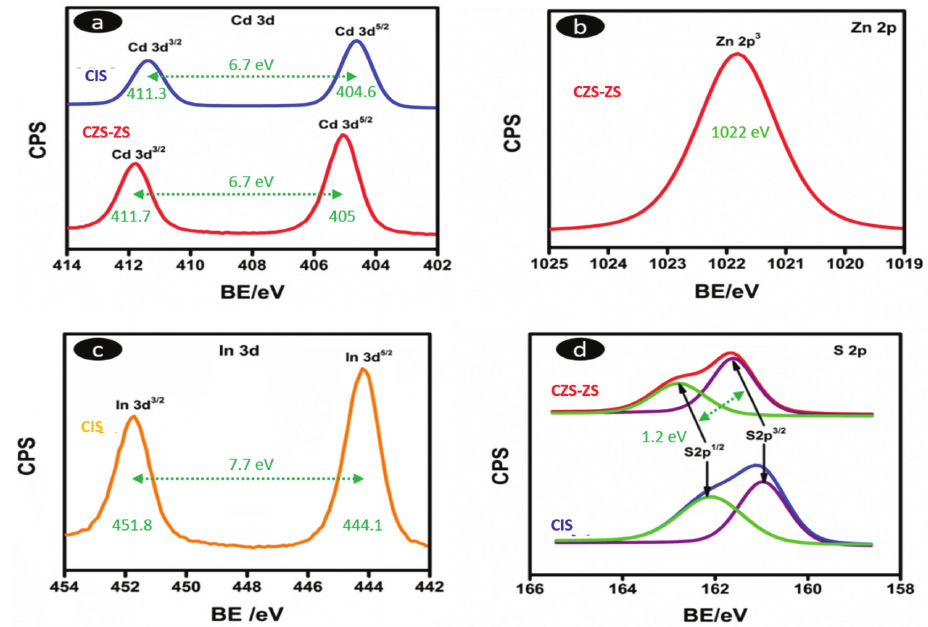
S and Cd Zn S -ZnS composite thin 2 4 7.23 2.77 10